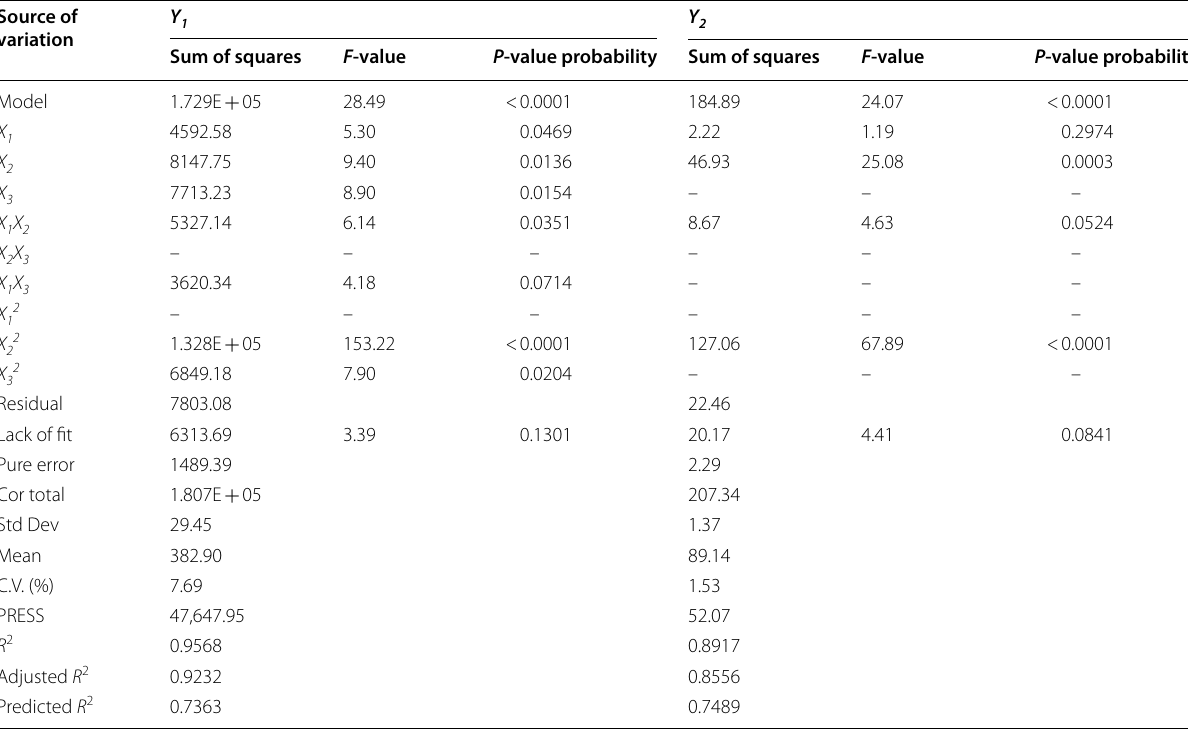
Table 1 ANOVA data of regression parameters of the Box–Behnken design experiment Source of